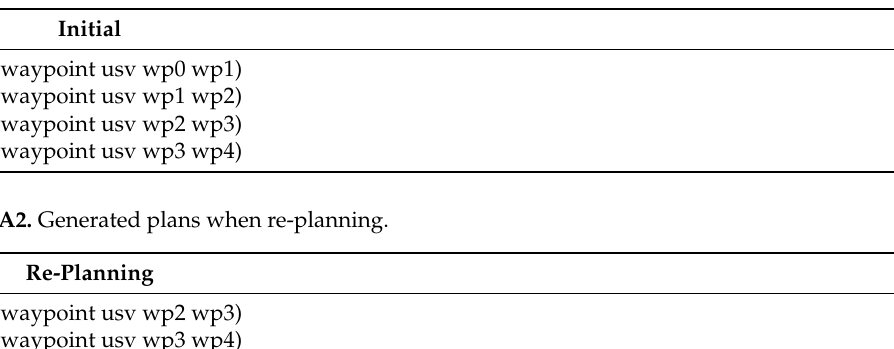
Table A1. Initial generated plans.